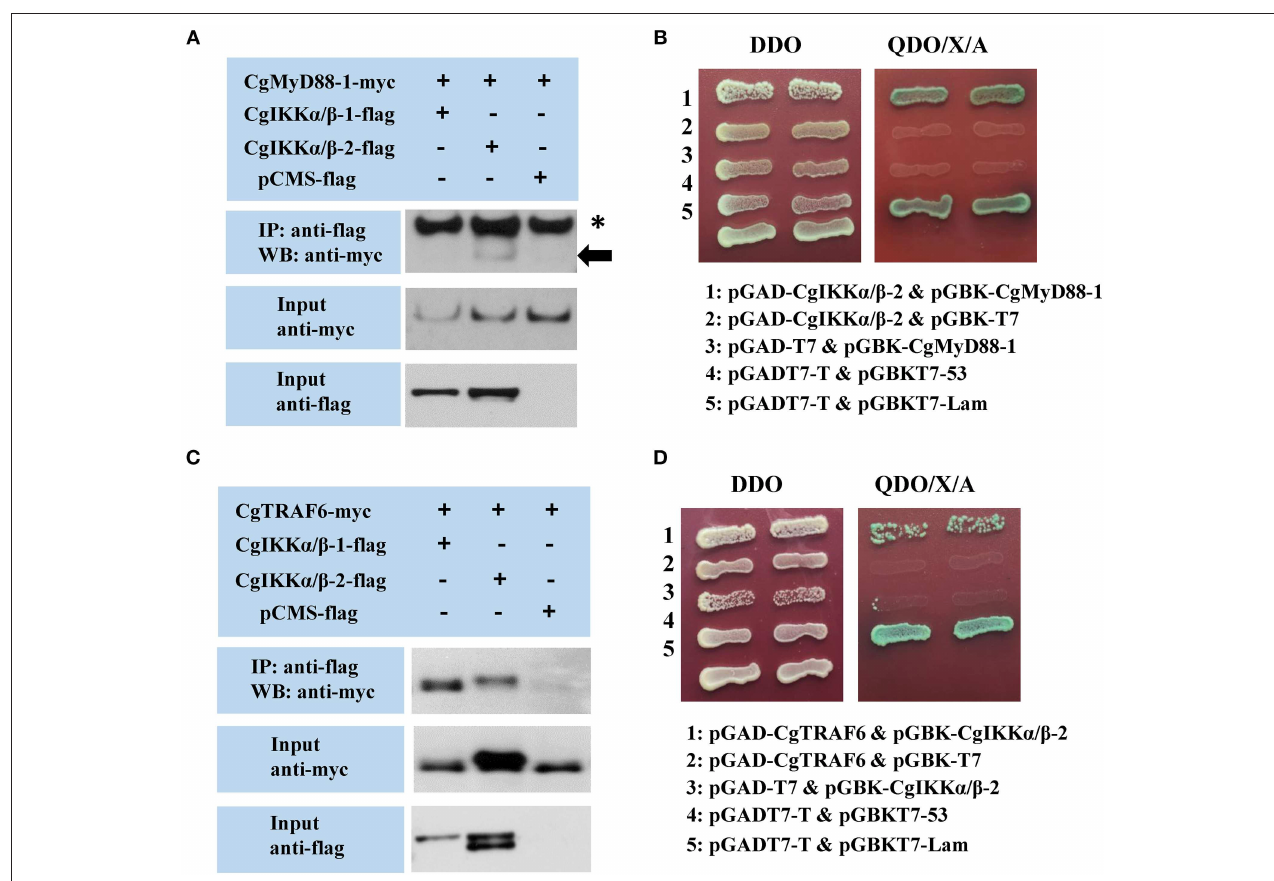
FIGURE 6 | Interactions between oyster IKK α / β s and other proteins detected by co-immunoprecipitation (Co-IP) and yeast two hybrid (Y2H) assays. (A) Co-IP results showing that CgMyD88-1 directly interacts with CgIKK α / β -2 but not with CgIKK α / β -1. Asterisk represents the heavy chain of mouse IgG. Anti-Myc western blot bands show the expression of CgMyD88-1-Myc and anti-FLAG western blot bands show the expression of CgIKK α / β -1-FLAG and CgIKK α / β -2-FLAG. (B) Interaction between CgIKK α / β -2 and CgMyD88-1 was detected by Y2H assay. DDO, -Leu/-Trp double-dropout media; QDO/X/A, -Ade/-His/-Leu/-Trp quadruple dropout media with X- α -Gal and aureobasidin A. pGADT7-T and pGBKT7-53 were used for the positive control; pGADT7-T and pGBKT7-Lam were used for the negative control. (C) Co-IP results showing that CgTRAF6 directly interacts with CgIKK α / β -1 and CgIKK α / β -2. Anti-Myc western blot bands show the expression of CgTRAF6-Myc and anti-FLAG western blot bands show the expression of CgIKK α / β -1-FLAG and CgIKK α / β -2-FLAG. (D) Interaction between CgIKK α / β -2 and CgTRAF6 was detected by Y2H assay.